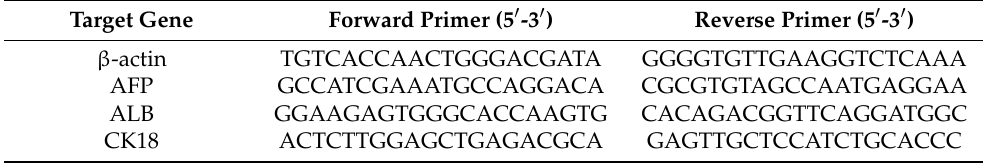
Table 1. Sequences of the primers used in RT-qPCR assay. Target